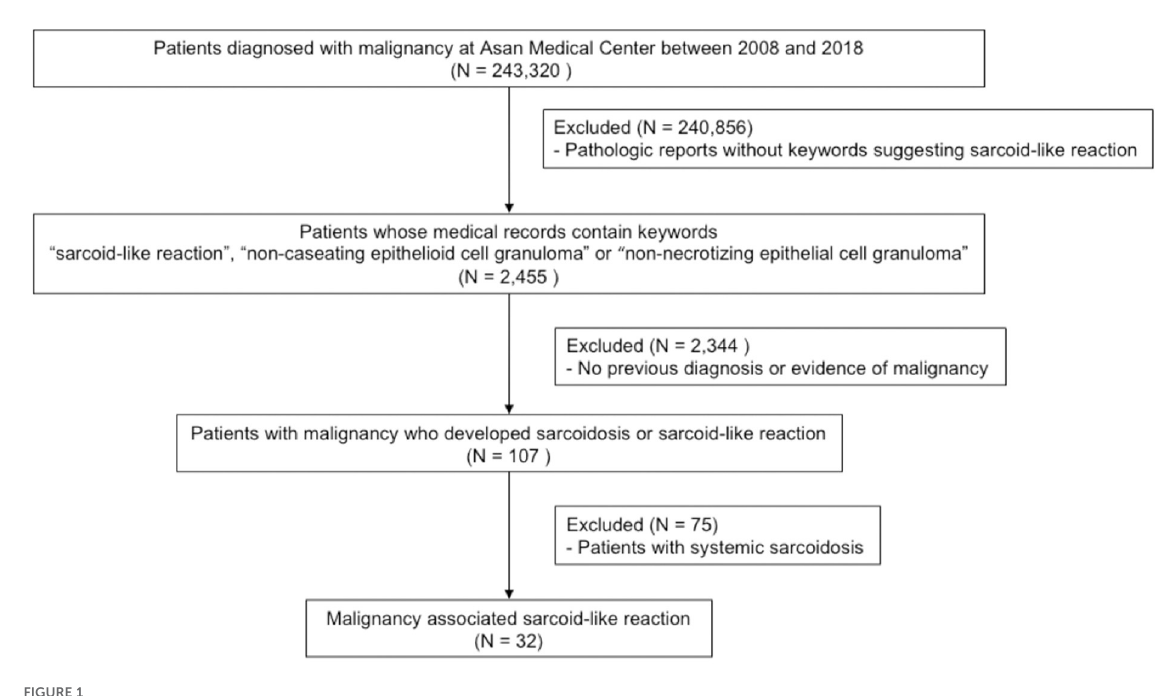
FIGURE1 Flowchart of the